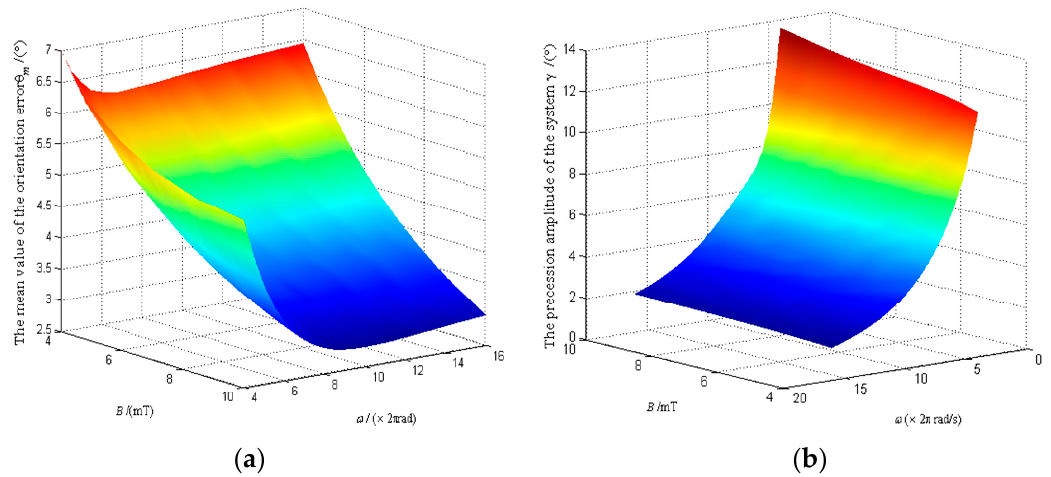
Figure 12. Variation law of the polar axis n f with ω and B. ( a ) Variation of orientation error θ m with ω and B ; ( b ) Variation of precession amplitude γ with ω and B .